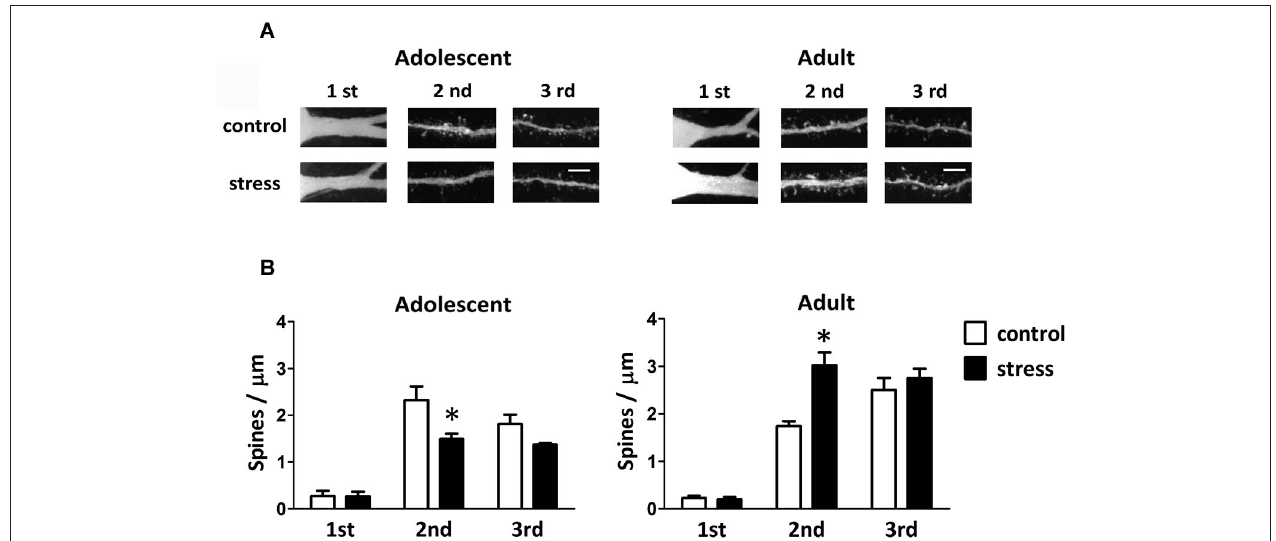
chronic social instability stress treatment. Scale bar = 5 µ m. (B) Quantitative results of the spine density at different order dendrites. * Significantly different between respective control and stress groups, two-way ANOVA followed by Bonferroni’s post hoc test.